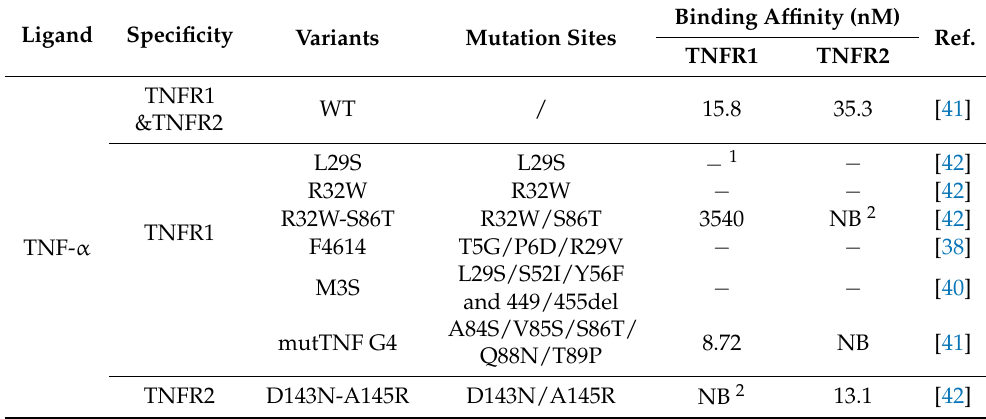
Table 1. The mutation sites and binding affinity of the receptor-specific TNF- α variants. Ligand